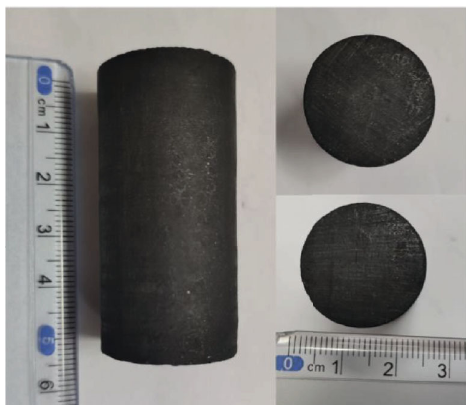
Figure 1: Photograph of the cylindrical core